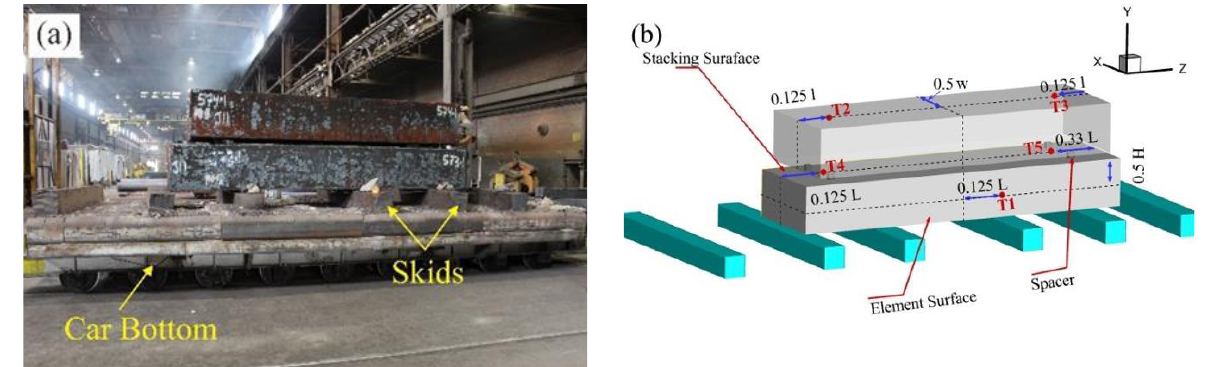
Figure 3. Experimental setup details including ( a ) real-scale experimental configuration and ( b ) a schematic view of five thermocouples’ locations (T1–T5).